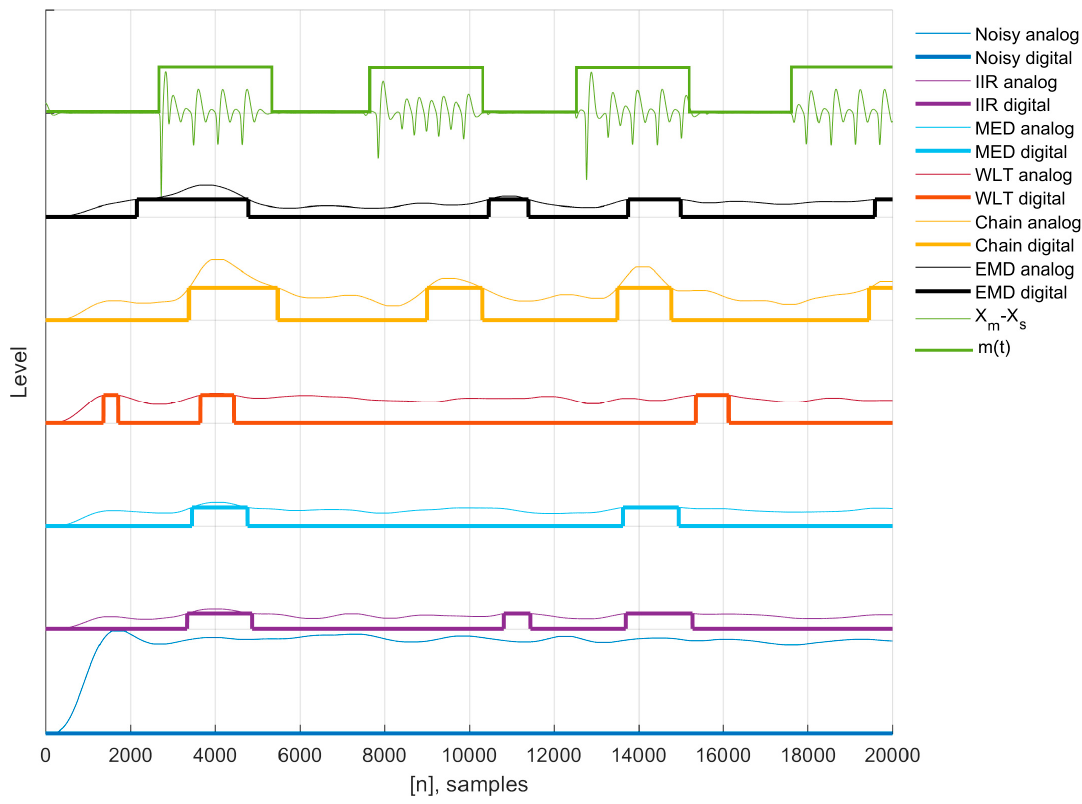
Figure 13. Example of a message recognition, SNR = − 10 dB. Noisy analog indicates without filtering; IIR indicates 4-th order low-pass Butterworth filter; MED indicates median filter; WLT indicates maximal overlap discrete wavelet transform filter using external phase Daubechies wavelet with 8 vanishing moments; EMD indicates conventional EMD filter; Chain indicates 4 driven oscillators chain filter; X m − X s indicates master-slave synchronization error with no noise in channel; m(t) indicates original digital message waveform.